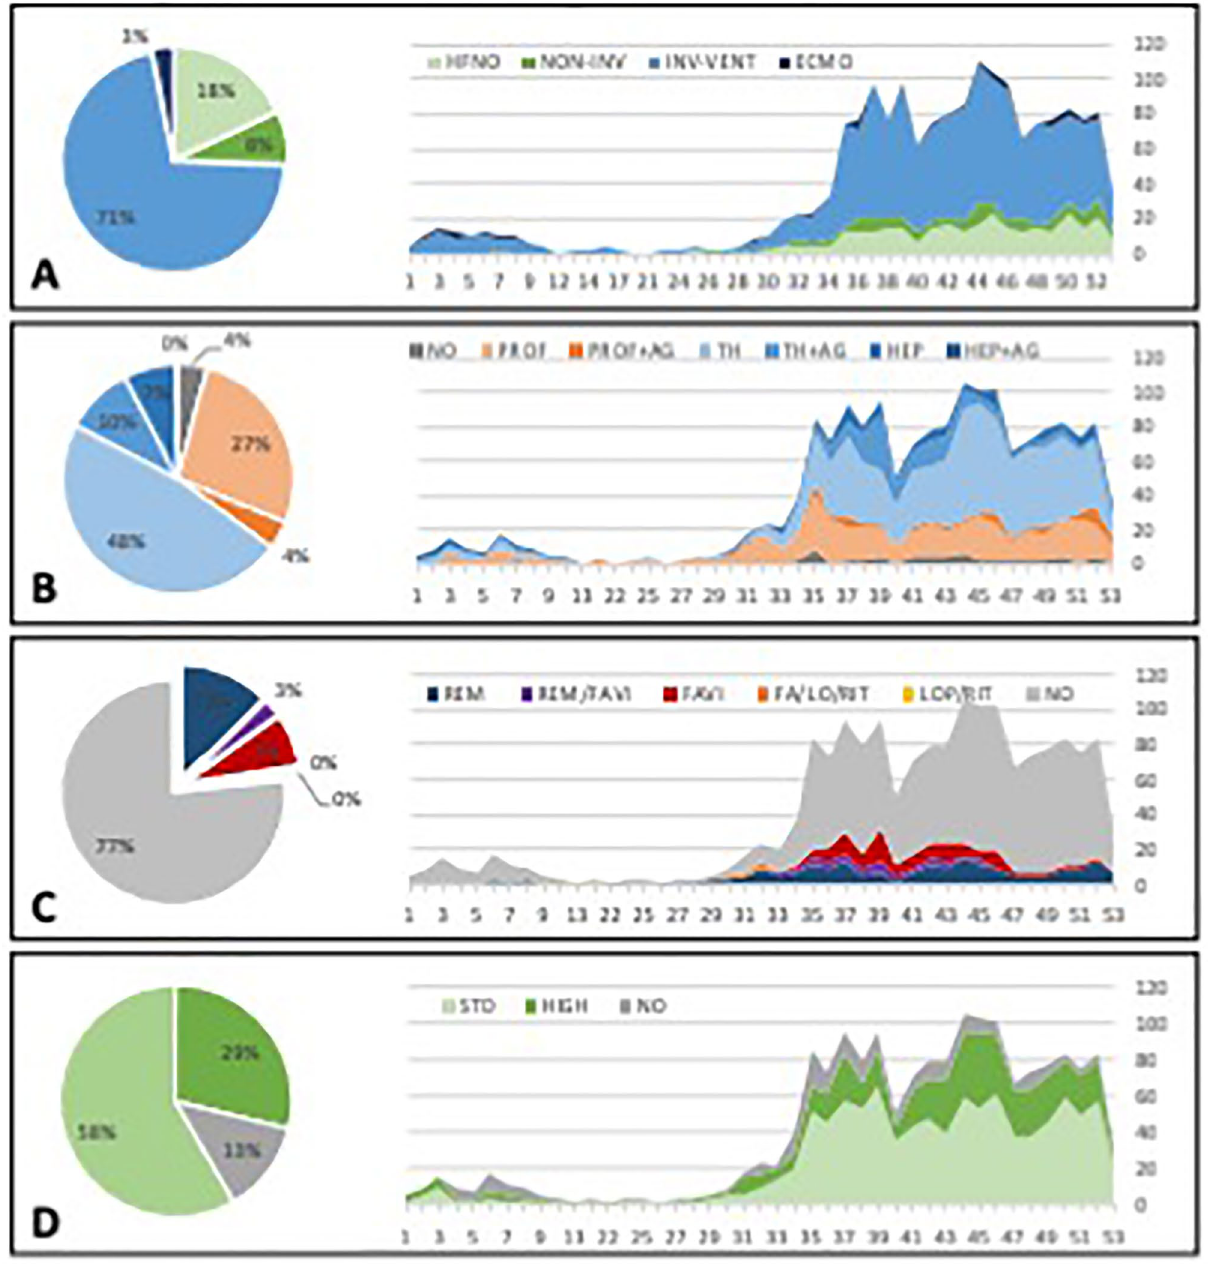
Figure 4. Disease specific treatment modalities. Each treatment modality is displayed as a pie plot for overall distribution and time-based evolution during the study (X-axis—study inclusion week, Y-axis—absolute number of patients). Respiratory support ( A ): high-flow nasal oxygen (HFNO, light green); non-invasive ventilation (NON-INV, dark green); invasive mechanical ventilation (INV-VENT, light blue); extracorporeal oxygenation (ECMO, dark blue). Anticoagulation and anti-aggregants ( B ): no anti-thrombotics (NO; grey); prophylactic low-molecular weight heparin (PROF, light orange); prophylactic low-molecular weight heparin + anti-aggregants (PROF + AG, dark orange); therapeutic low-molecular weight heparin (TH, very light blue); therapeutic low-molecular weight heparin + anti-aggregants (TH + AG, light blue); heparin anticoagulation (HEP, dark blue); heparin anticoagulation + anti-aggregants (HEP + AG—very dark blue). Antivirals ( C ): no antivirals (NO, grey); remdesivir (REM, dark blue); favirapivir (FAVI, red); lopinavir- ritornavir combination (LOP/RIT, yellow) and their potential combinations. Corticosteroids ( D ): without steroids (NO, grey); standard dose of dexamethasone 6-8 mg/day equivalents (STD, light green); any higher dose (HIGH, dark